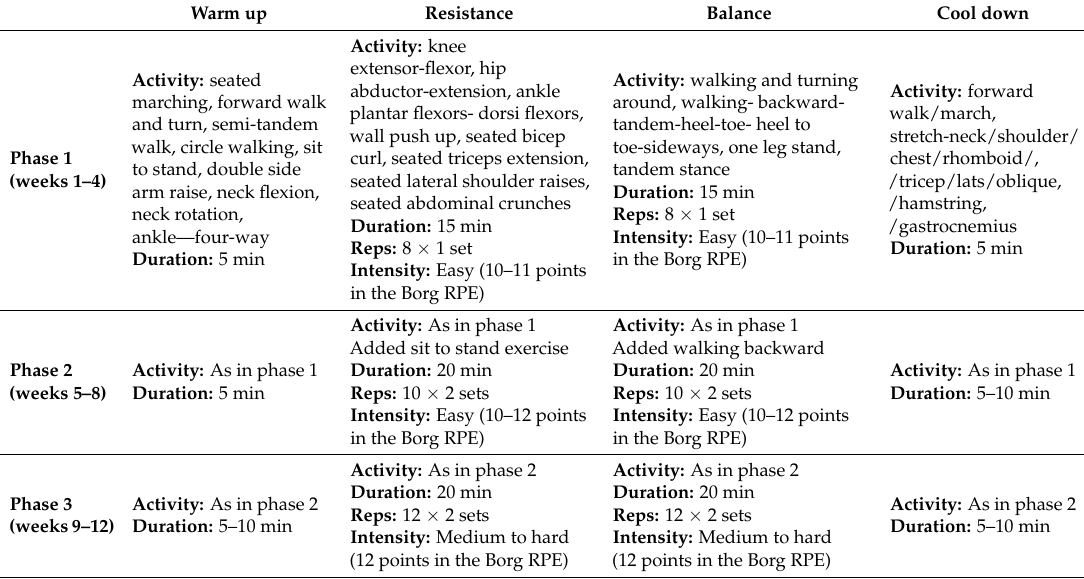
Table 1. Exercise intervention